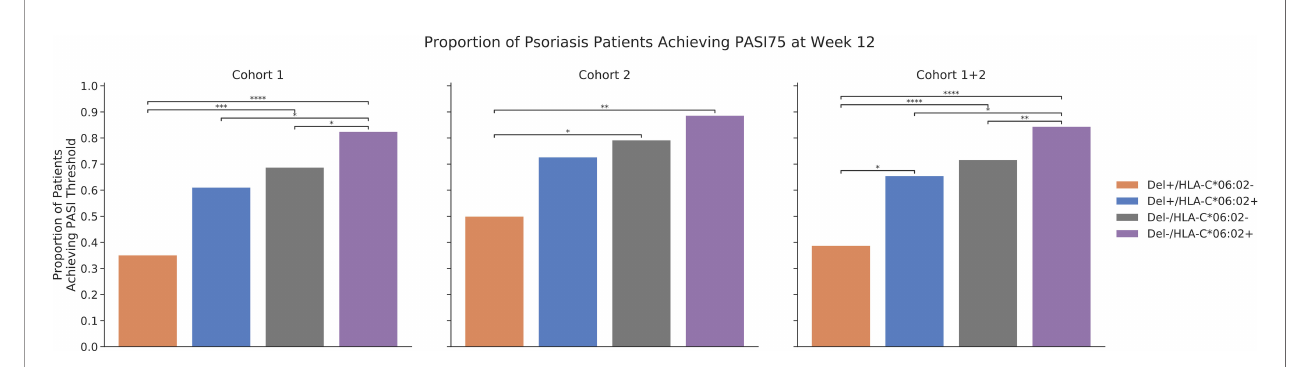
FIGURE 4 | Proportion of psoriasis patients achieving PASI75 at week 12. * P <=5×10 -2 ; ** P <=1×10 -2 ; *** P <=1×10 -3 ; **** P <=1×10 -4